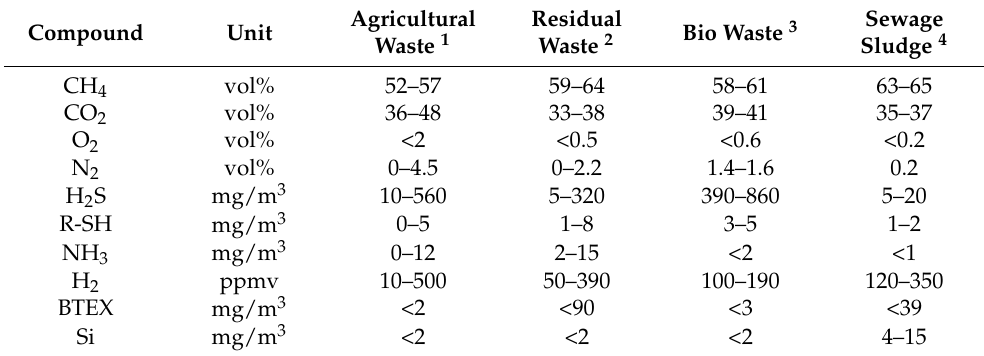
Table 1. Average concentrations of the individual biogas components for different substrate groups, according to